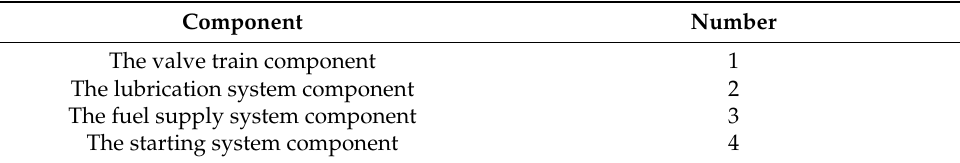
Table 2. Component numbers of the power transmission device.